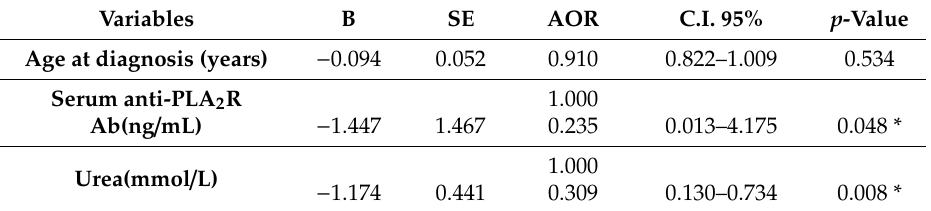
Table 5. Multiple logistic regression for the prognostic outcome of primary MGN using eGFR (CKD ≥ 3). Variables B SE AOR C.I. 95%